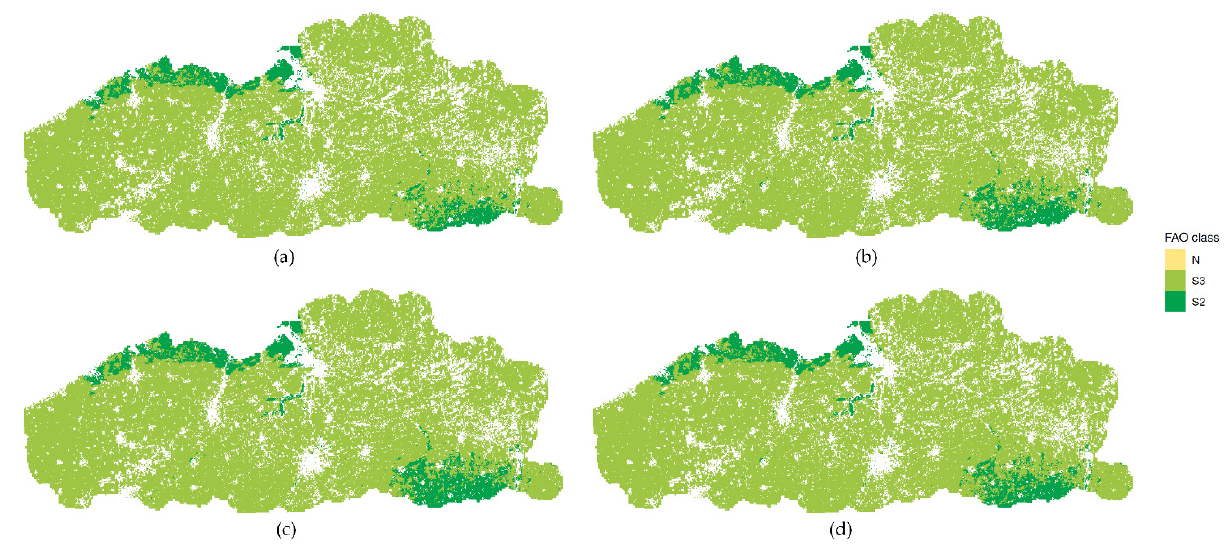
Figure 6. LS classes (S1, S2, S3, N) after 100 years of SICS for maize in Flanders, where ( a ) Conservation Tillage (CT); ( b ) Cover Crop (CC); ( c ) Crop Residue Management (CRM); ( d ) Manure Application (MA) .